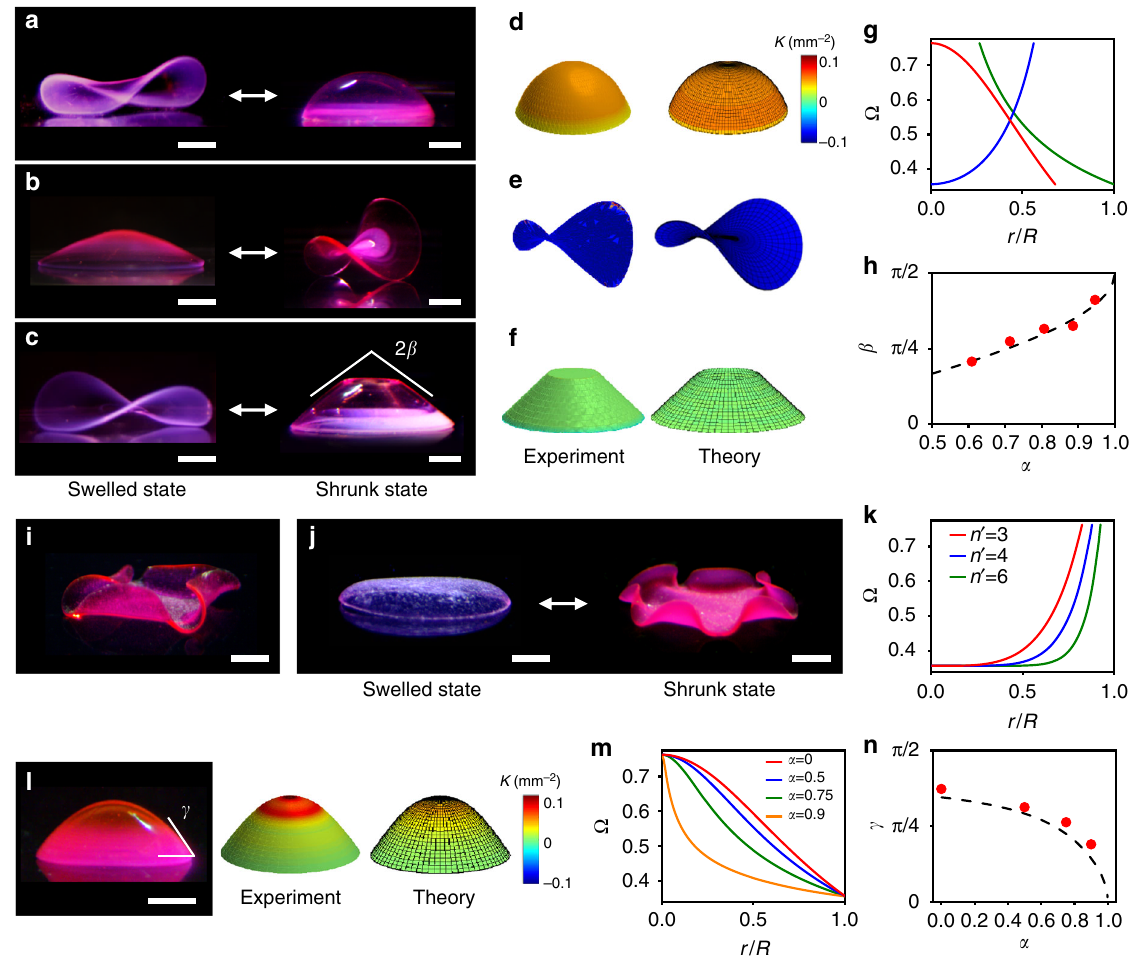
Fig. 2 Shape-morphing 3D structures with axisymmetric metrics. a – c 3D structures with constant Gaussian curvature K at the shrunk state (right) and the corresponding structures at the swelled state (left): spherical cap ( a ), saddle ( b ), and cone ( c ) shapes. d – f Reconstructed 3D images with K of experimental (left) and theoretical (right) shapes of the spherical cap ( d ), saddle ( e ), and cone ( f ) structures in a – c . g Ω used to form the structures in a – c : red line (spherical cap), blue line (saddle), and green line (cone). h Experimental (solid circles) and theoretical (dashed line) values of β with different α in Ω for cone structures. i , j Enneper ’ s minimal surfaces with n ′ wrinkles: n ′ = 4 ( i ) and 6 ( j ). The structure reversibly transforms between prescribed 3D shapes at the swelled (left) and shrunk (right) states as shown in j . k Ω used to form the Enneper ’ s minimal surfaces with n ′ wrinkles in i , j and Supplementary Figure 5: Ω with n ′ = 3 (red line), n ′ = 4 (blue line), and n ′ = 6 (green line). l Experimentally constructed 3D structure with a smooth gradient in K (left) and reconstructed 3D images with K of the experimental (middle) and theoretical (right) structures. γ is the base angle of the structures. m Ω with different α used to form the structures in l and Supplementary Figure 6: Ω with α = 0 (red line), α = 0.5 (blue line), α = 0.75 (green line), and α = 0.9 (orange line) (Supplementary Note 4). n Experimental (solid circles) and theoretical (dashed line) values of γ of the structures formed with Ω in m as a function of α . Scale bars, 5 mm (left), 2 mm (right) in a – c ; 2 mm in i ; 5 mm (left), 2 mm (right) in j ; 2 mm in